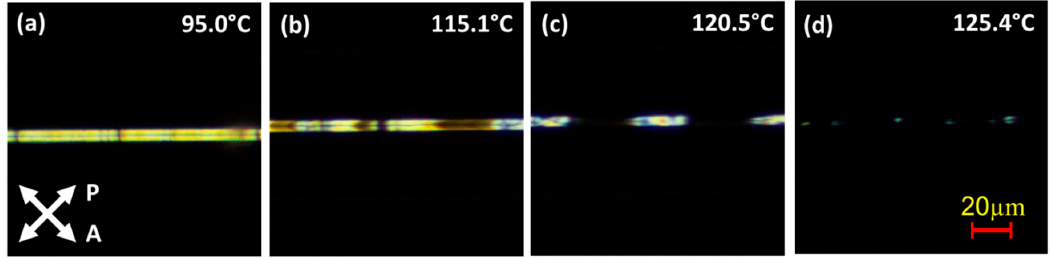
Figure 3. A mesophase–isotropic phase transition for a 6-µm microcapillary infiltrated with 0.1% wt. GNPs in W212 FLC. ( a ) Before the phase transition, ( b ) beginning of the phase transition, ( c ) during the phase transition, ( d ) end of the phase transition. Table 1. Mesophase–-isotropic phase transition for a 6- µ m microcapillary infiltrated with different concentrations of GNPs in W212 FLC.